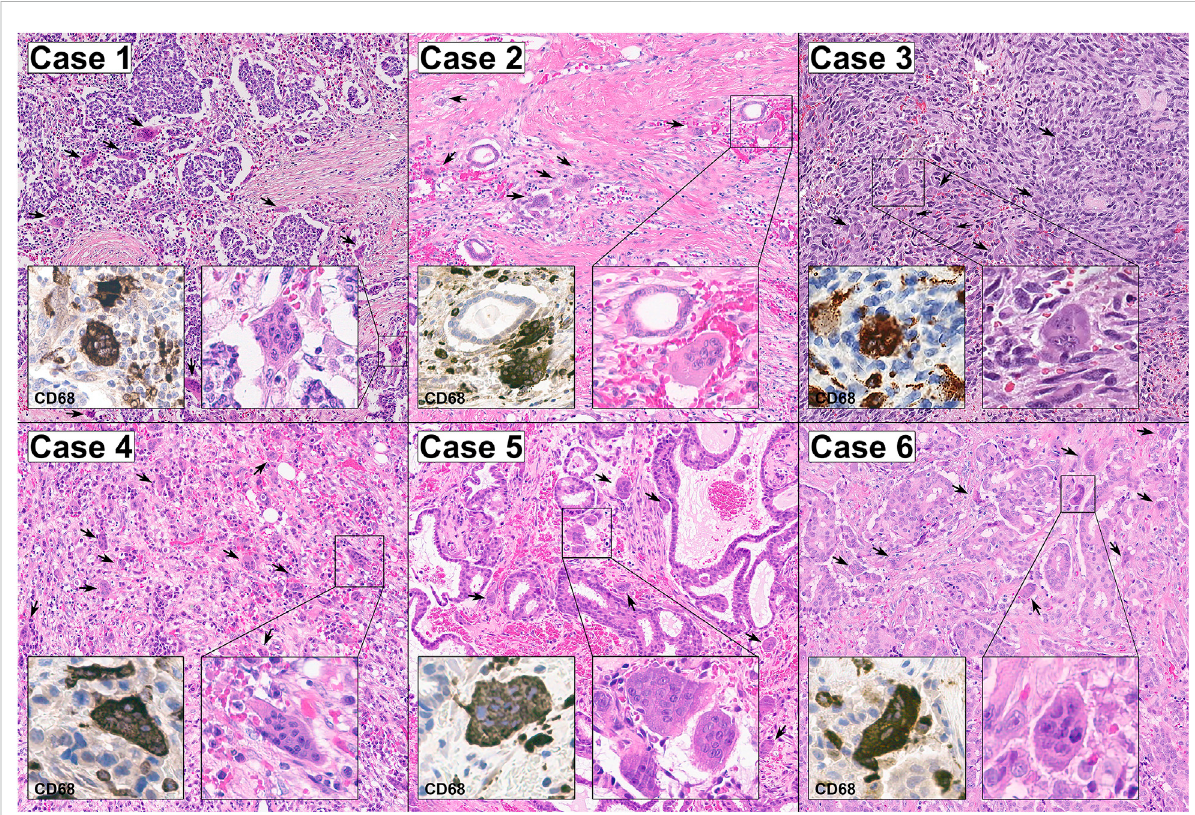
FIGURE 1 Representative micrographsofthesixbreastcancerswithOSGCincludedinthisstudy.Thestromaofall caseswashypervascular/hemorrhagic and populated by OSGC (arrows) within an activated tumor immune microenvironment characterized by the presence of tumor-in fi ltrating lymphocytes (TILs) with a relatively high proportion of tumor-associated macrophages (TAMs). The OSGC were characterized by an abundant eosinophilic cytoplasm with several non-atypical nuclei with evident nucleoli. At immunohistochemical analysis, both OSGC and TAMs were CD-68 positive. Original magni fi cation ×100; insets